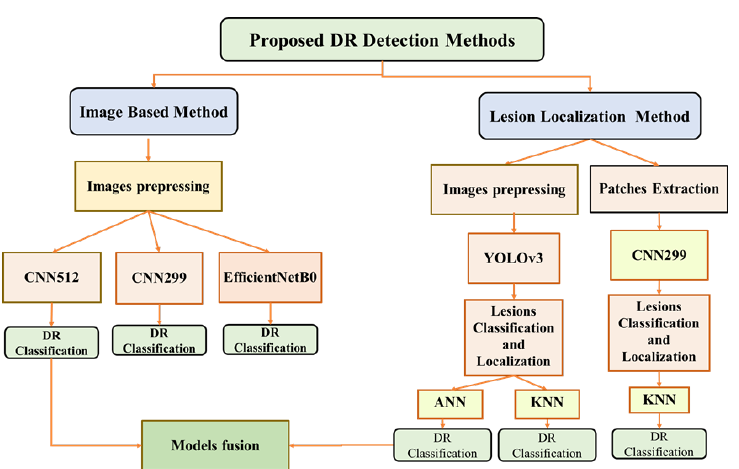
Figure 5. Block diagram of the different proposed models for DR images classification and